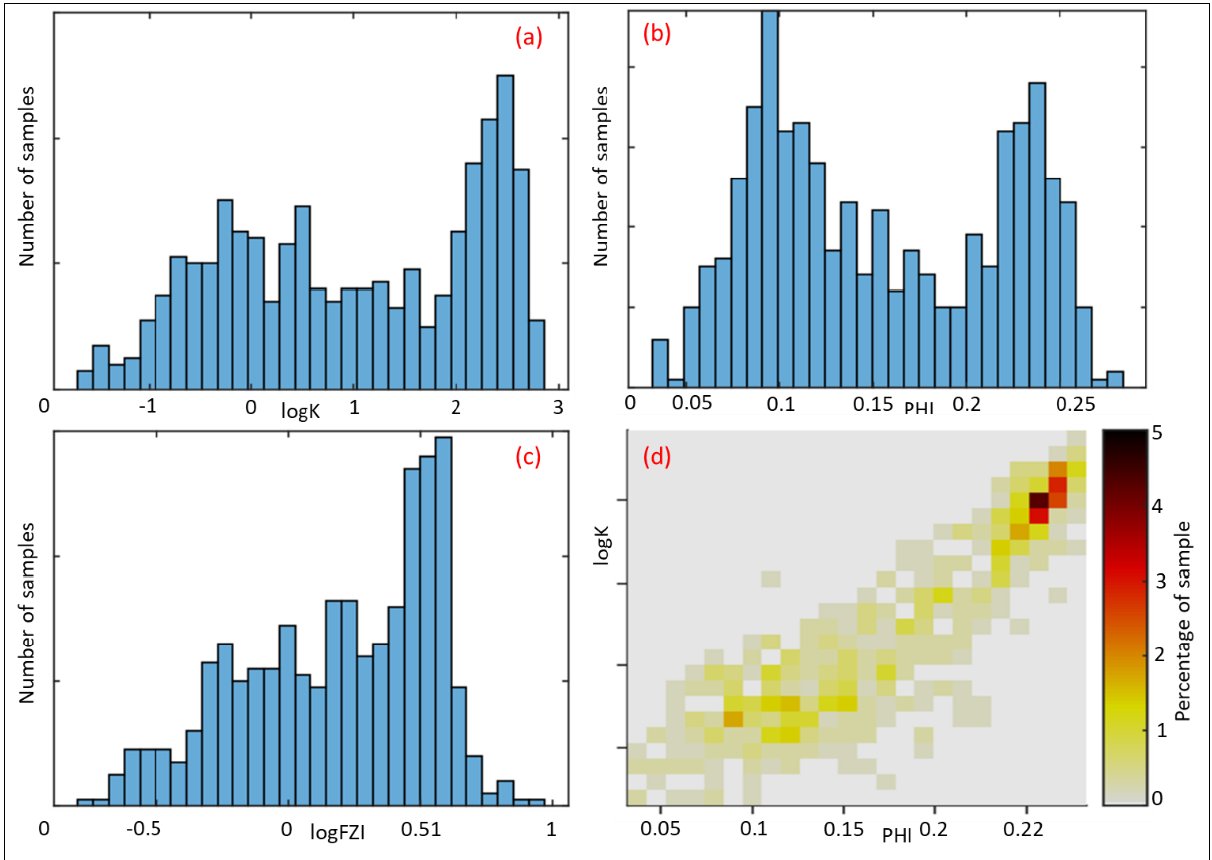
Figure 4. The 587 cores data from 4 wells: ( a ) Histogram of permeability, ( b ) Porosity, ( c ) FZI and ( d ) Cross plot of permeability versus porosity and density of data.